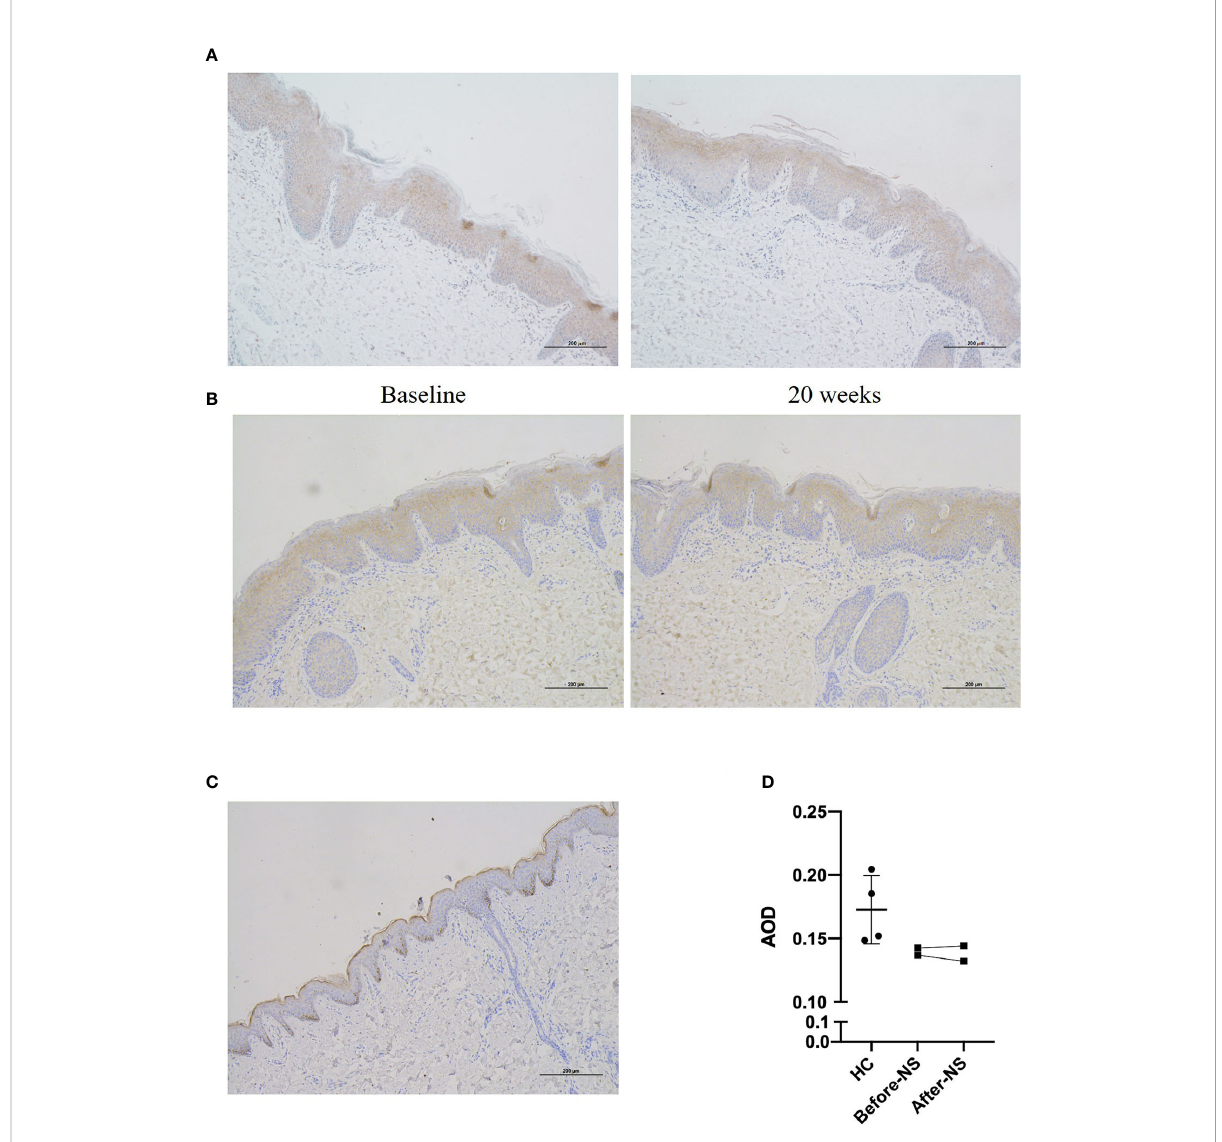
FIGURE 4 Expression of LEKTI protein in skin lesions of patients after 20 weeks of dupilumab treatment (A, B) show immunohistochemical staining of skin lesion for LEKTI before and after 20 weeks of dupilumab treatment in patients 1 and 4, respectively. Both patients showed a signi fi cant reduction in LEKTI expression compared with that of HCs. (C) LEKTI expression in HCs as a positive control: LEKTI is expressed strongly in the cytoplasm of keratinocytes in the epidermal granular and uppermost spinous layers. (D) Average optical density (AOD) was analyzed. The results suggest that LEKTI expression was signi fi cantly lower in the lesion skin of both patients than that of HCs and there was no obvious change after dupilumab